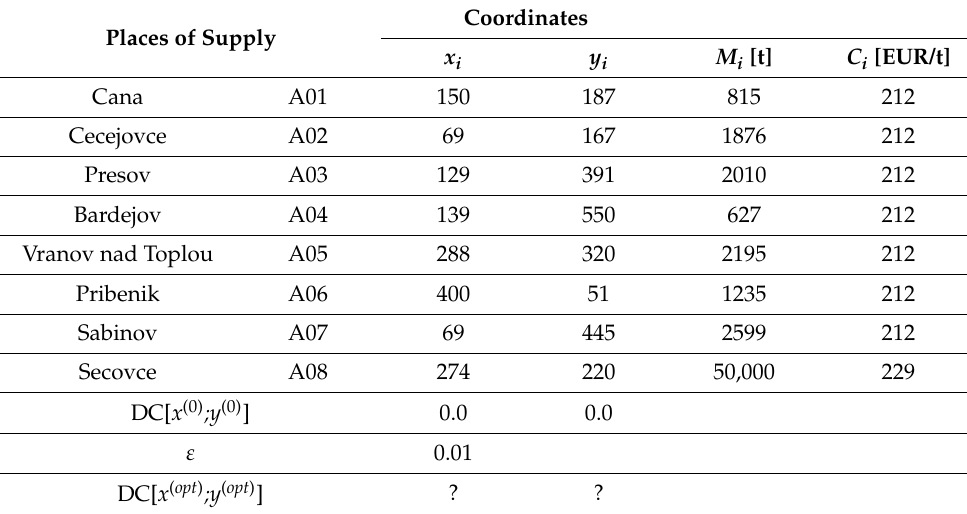
Table 4. Defined coordinates of the places of supply in the calculation, and their unit quantities, unit prices, selected accuracy.